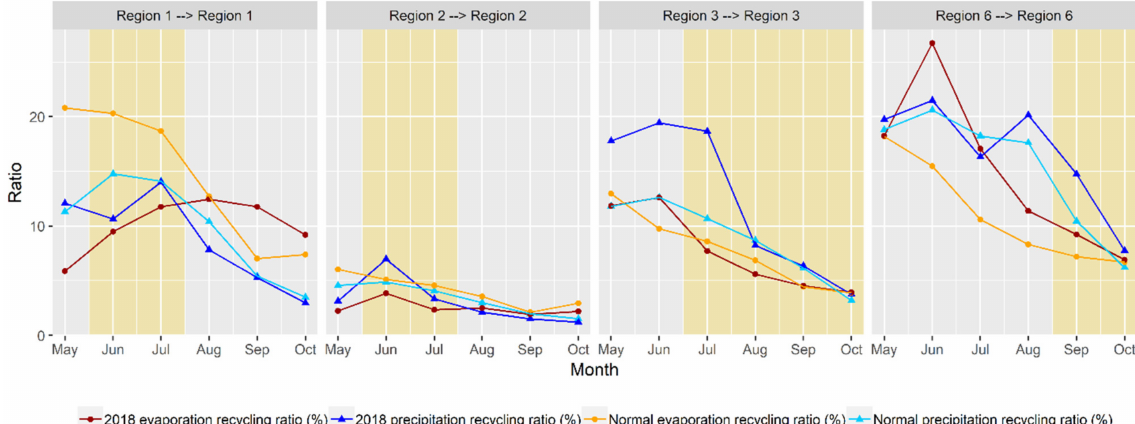
Figure 5. The 2018 monthly regional evaporation and precipitation recycling ratios (Equations (3) and (4)) of the drought regions 1, 2, 3 and 6. The location of these region is indicated in Figure 1. A yellow shading is applied when the month experiences drought (i.e., SMC of that month and NDVI of the following month percentiles <33.4). Note, regions 4 and 5 did not experience a strong drought (Figures 1–3) and were, therefore, not included